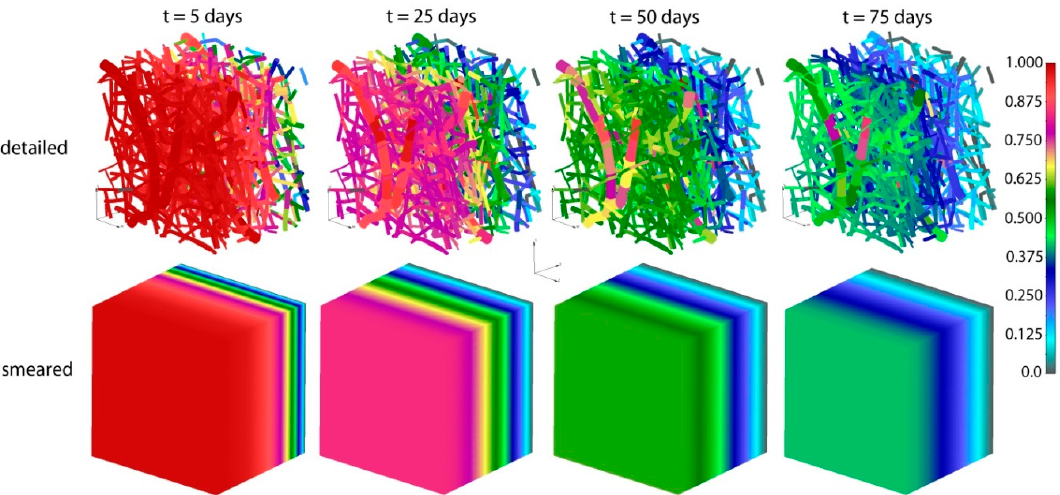
Figure 9. PLGA implant—concentration field for the detailed and smeared model, for the diffusion of Span-80/RhB complex within the PLGA